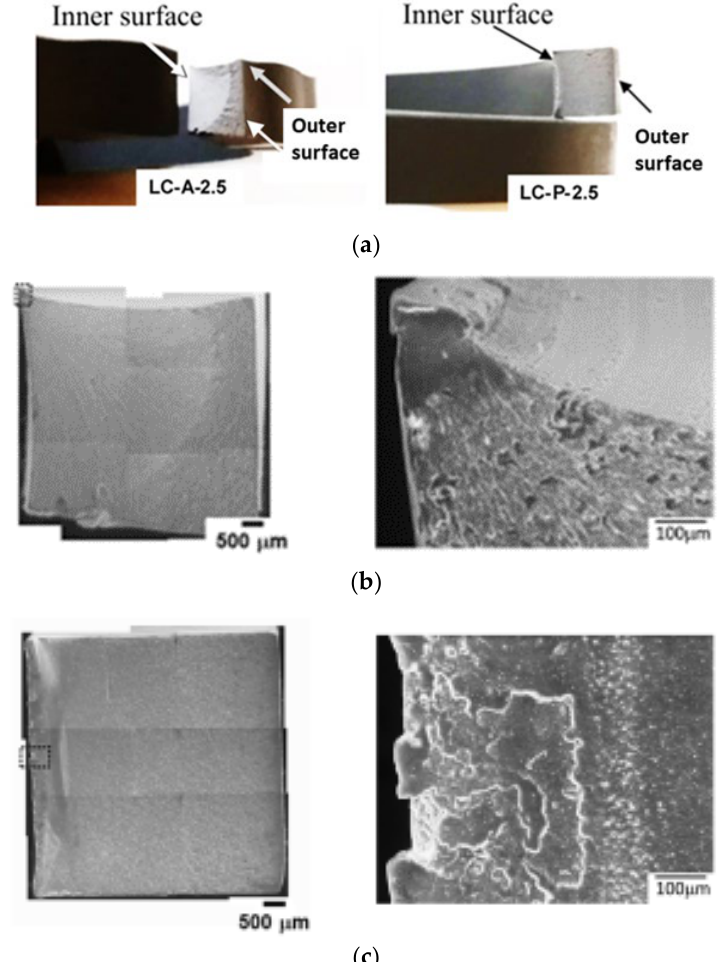
Figure 6. Fracture surfaces of pipe ring specimens after the treatment through local contact on the inner surfaces: ( a ) optical photographs showing the overall fracture surfaces, ( b ) SEM micrographs from an LC-A-2.5 specimen, and ( c ) SEM micrographs from an LC-P-2.5 specimen. For micrographs in ( b , c ), inner surface is on the left, and outer surface on the right.